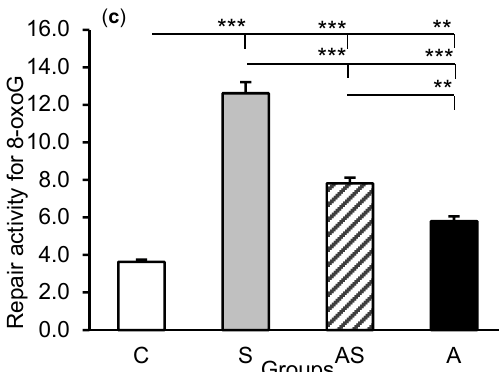
Figure 5. Repair activities (fmol / µ g protein / h) for 1, N 6 -ethenoadenine ( ε A), ( a ) 3, N 4 -ethenocytosine ( ε C), ( b ) and 8-oxoguanine (8-oxoG), ( c ) in the hippocampal CA1 field of sheep treated with: vehicle (C), vehicle and stressful stimuli (S), allopregnanolone and stressful stimuli (AS), and allopregnanolone alone (A). Significance of differences: ** p < 0.01, *** p < 0.001.